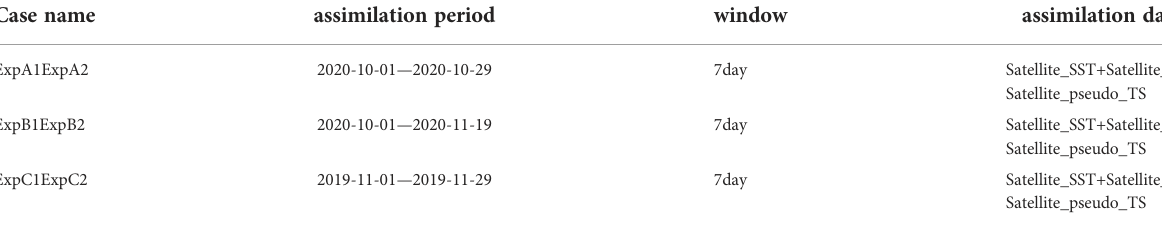
TABLE 2 Assimilation experiment